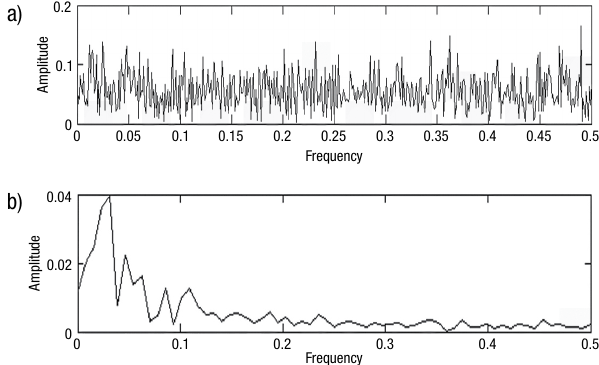
Fig. 12. Gaussian noise spectrum (a), Bund 1 minute – price series spectrum (b)